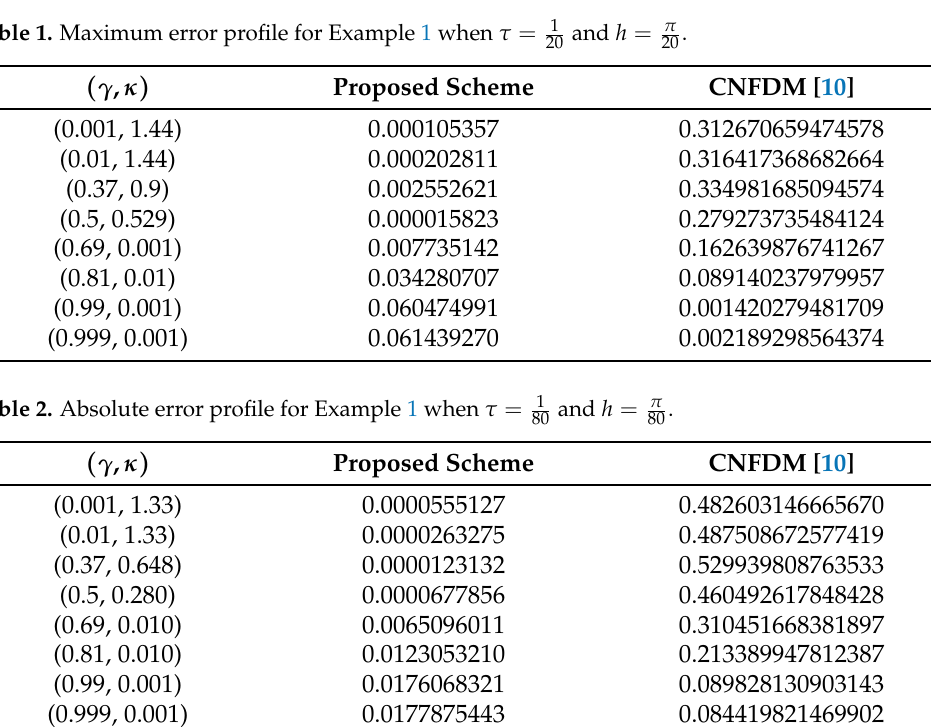
Table 1. Maximum error profile for Example 1 when τ = 1